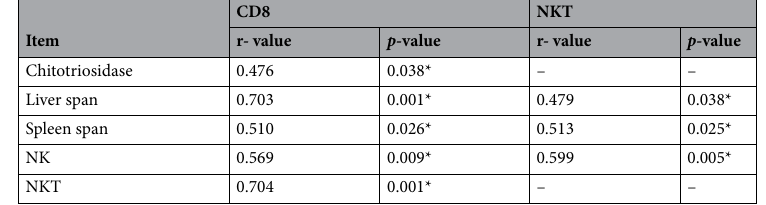
Table 3. Correlation between CD8 and NKT cells and different variables in GD patients. Pearson’s correlation coefficient test is used to determine correlation. CD cluster of differentiation, NK natural killer, NKT natural killer